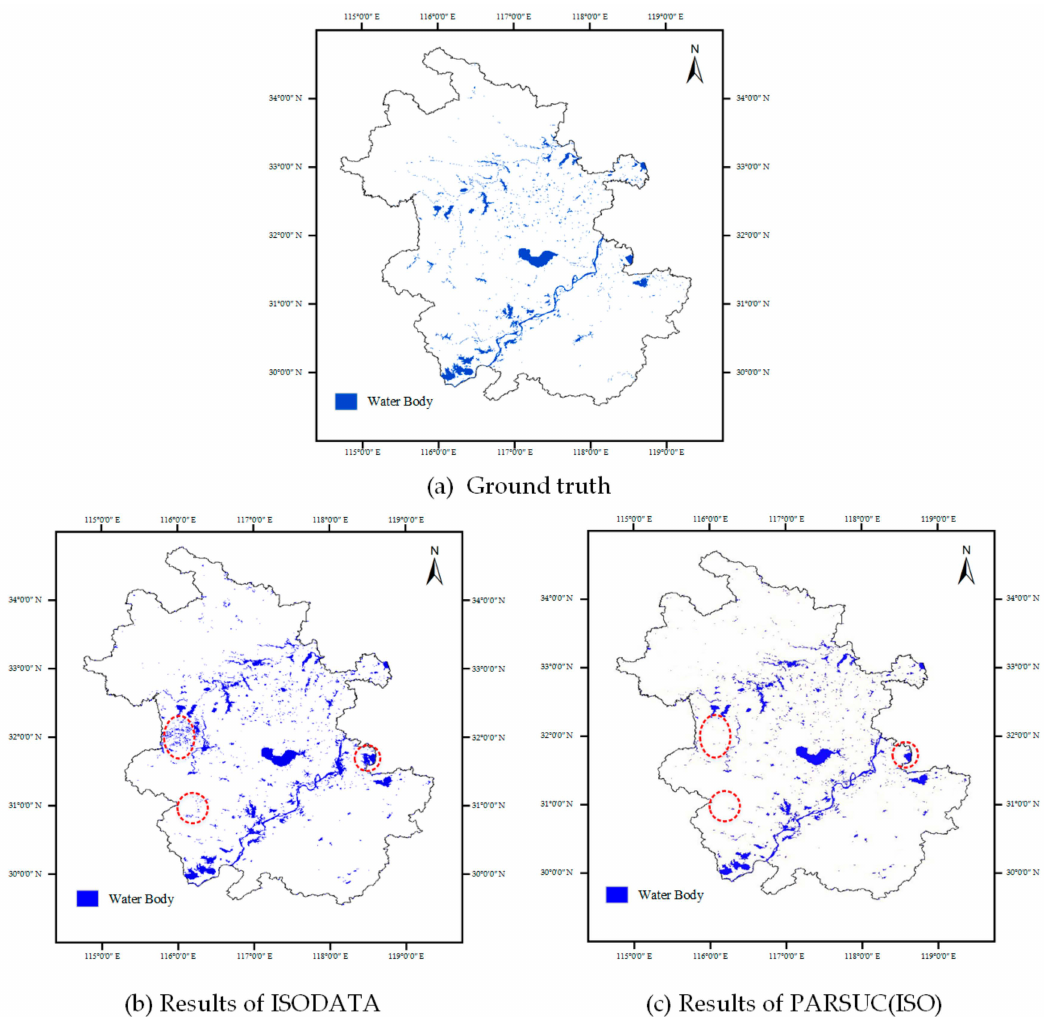
Figure 11. Ground truth, water body extraction results of ISODATA and